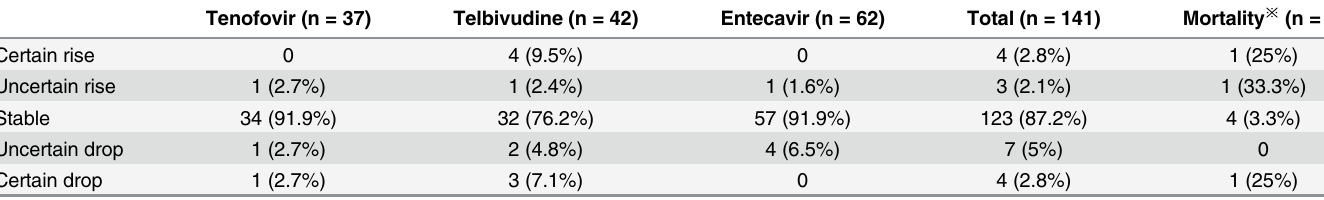
Table 2. A comparison of the change in renal function * between study